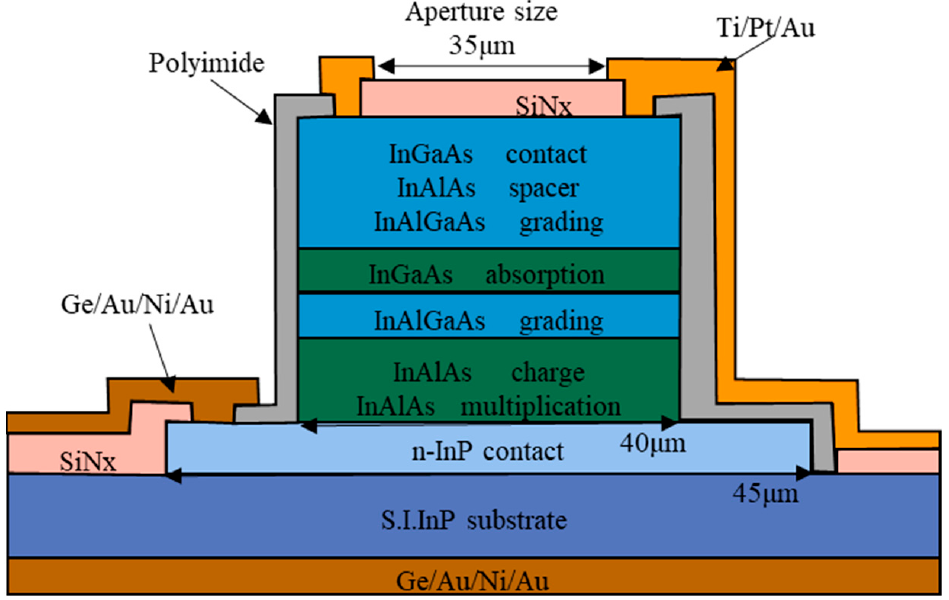
Figure 33. Cross-sectional diagram and top view image for the mesa geometry front-side illuminated InGaAs/InAlAs SAGCM APDs